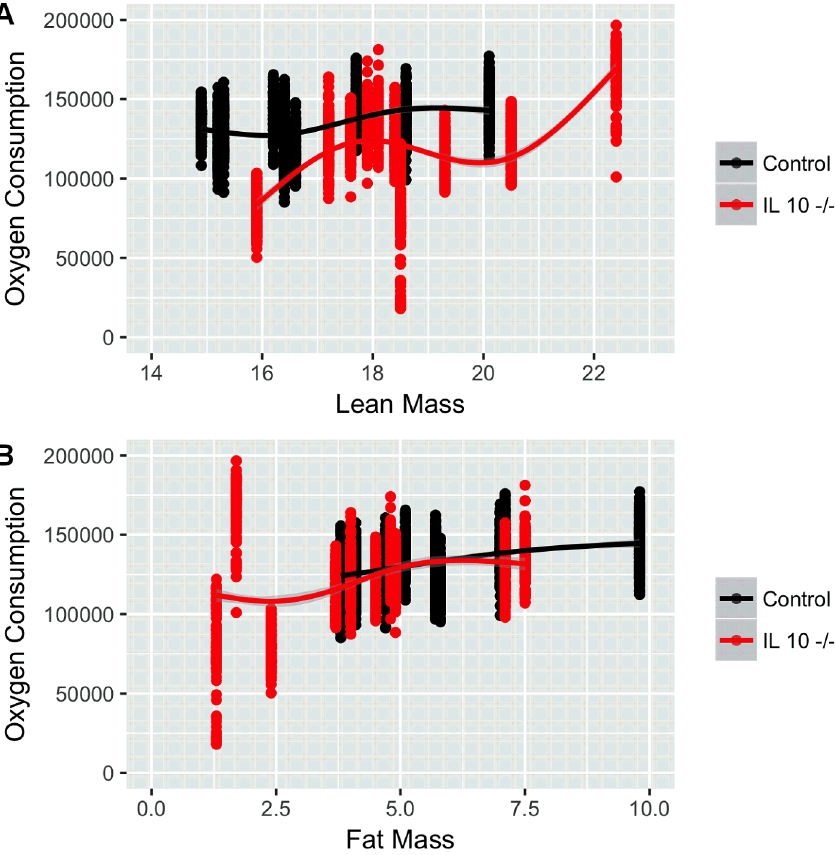
Fig 1. Oxygen consumption normalized by lean mass (top) and fat mass(bottom) in IL 10 tm (n = 10, 22 months old). (p < 0.0001:Fig 1A & Fig 1B respectively). Each animal’srange of 48 hour VO 2 is depicted by a singlevertical group of points with a line connecting the means of each animalacross each